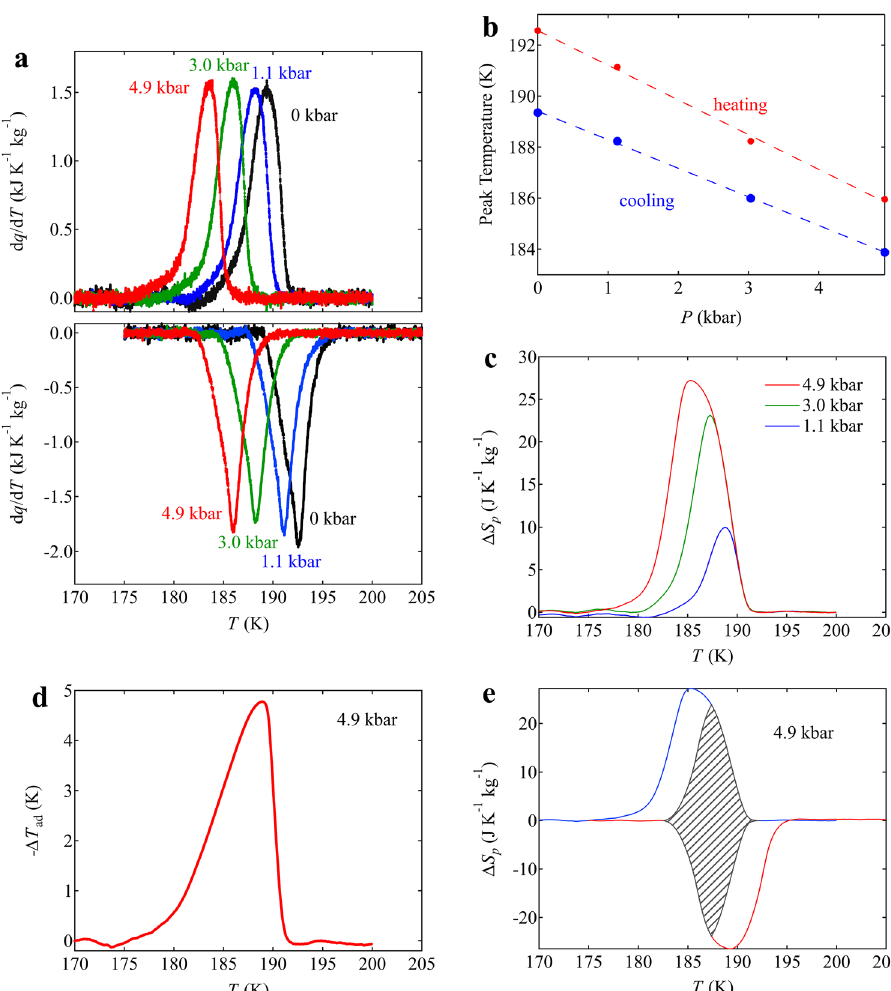
Figure 4. ( a ) Heat flow curves divided by cooling rates in BiCu 3 Cr 4 O 12 measured under applied pressure from 0 to 4.9 kbar. Heat flow curves on heating are also shown in the lower panel. ( b ) Pressure dependences of peak temperature of the heat flow. The dashed lines show the linear fits of the data. ( c ) Corresponding entropies as a function of temperature under various applied pressures. Entropy is calculated using the equation described in the method section. The entropies on cooling are relative to the value at 200 K. ( d ) Calculated adiabatic temperature change induced by applying pressure of 4.9 kbar. ( e ) Isothermal entropy changes in both cooling and heating at 4.9 kbar. The shaded area represents a region of reversible entropy